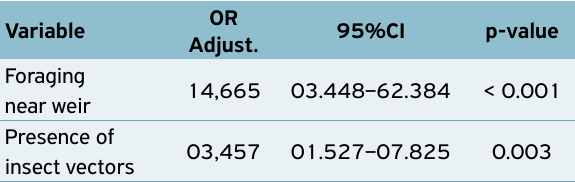
Table 1. Results of analyses of risk factors associated or not with T. vivax infection in cattle in the Mossoró/RN microregion, 2013, with the respective odds ratio (OR), confidence interval (CI) and statistical significance.